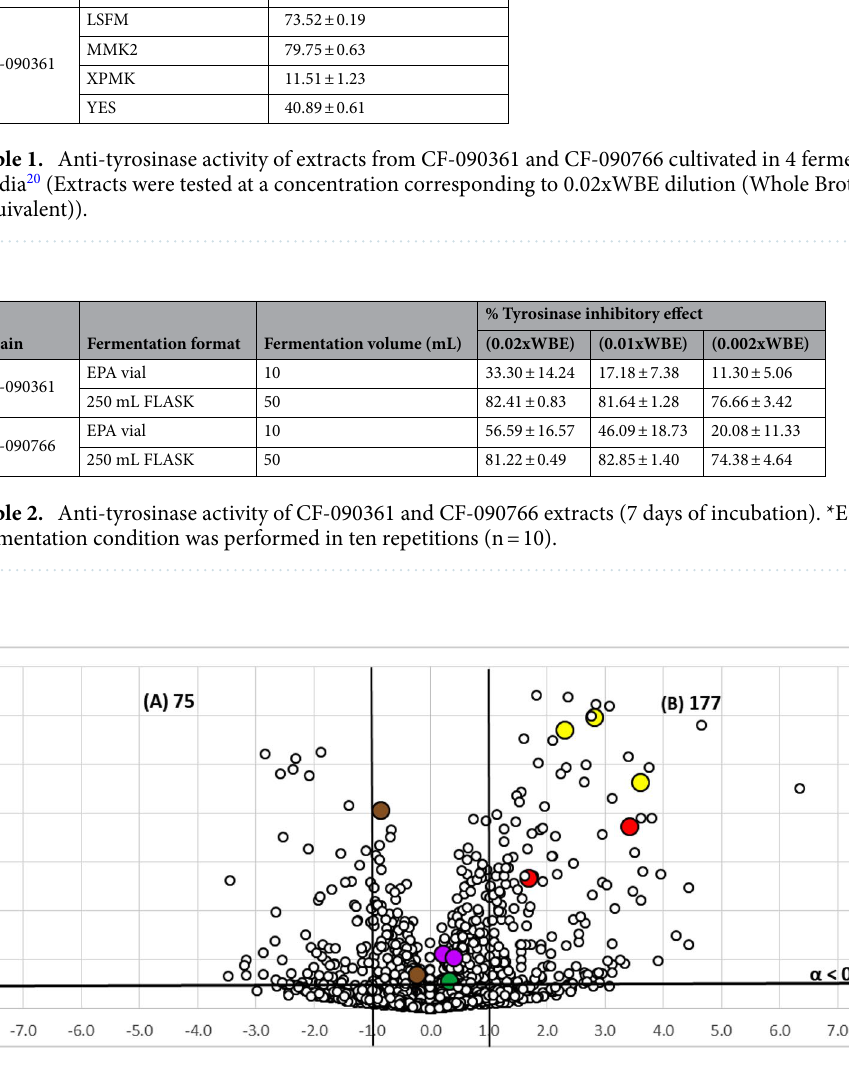
Figure 2. Volcano-plot statistical untargeted metabolomics comparison of the two fermentation formats tested for the strain CF-090361, comparing the different growth conditions (− log 10 of t-test statistical p-value in y-axis vs. − log 2 of ion masses areas ratio in x-axes): ( A ) culture in EPA vials; ( B ) culture in Flasks of 250 mL ( m/z 219 and m/z 220 in red, m/z 205 and m/z 206 in purple, m/z 197 and m/z 198 in brown, m/z 223, m/z 241 and m/z 263 in yellow and m/z 322 in green). The number of statistically different mass ions due to higher production for each growth condition is indicated with statistical confidence of 95% (n = 10; α < 0.05) for each fermentation